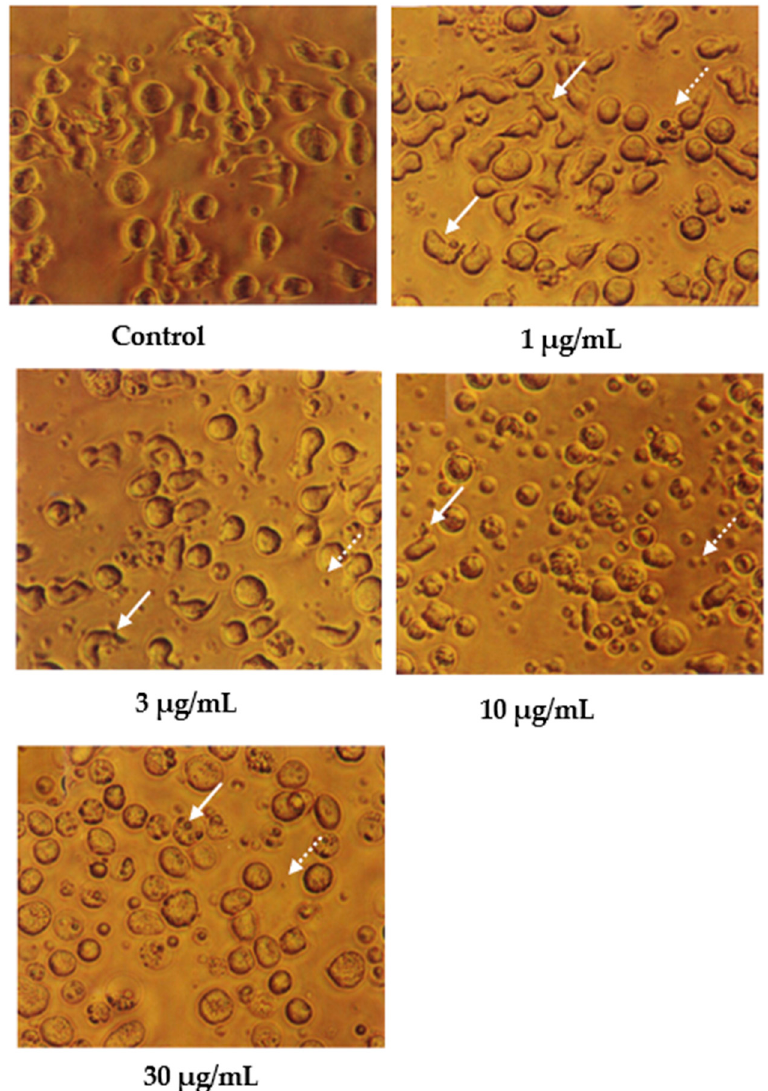
Figure 2. CEM-SS cells without treatment (control) or treated with different concentrations of nordamnacanthal for 24 h (200 × magnification). Complete arrows indicate apoptotic cells, and dotted arrows indicate necrotic cells.